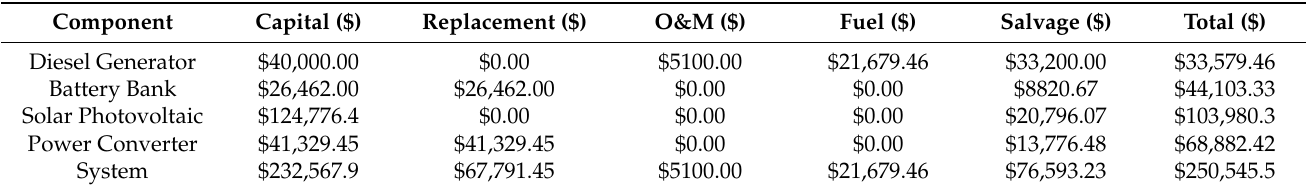
Table 4. Cost status of the proposed optimum system.